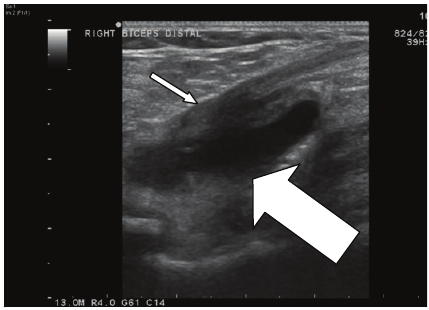
Figure 4: US image. Bicep tendon insertion to radius (thin arrow). Bursa (thick arrow).